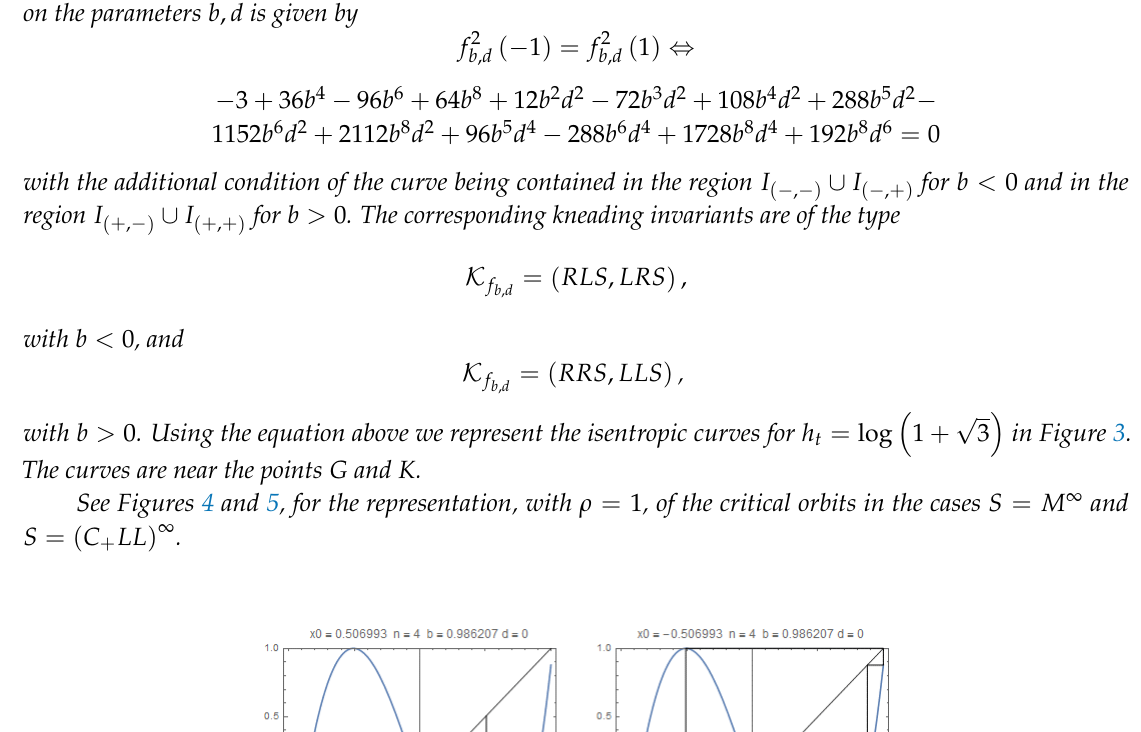
√ 3 and r = − 3 s ( s + 1 )